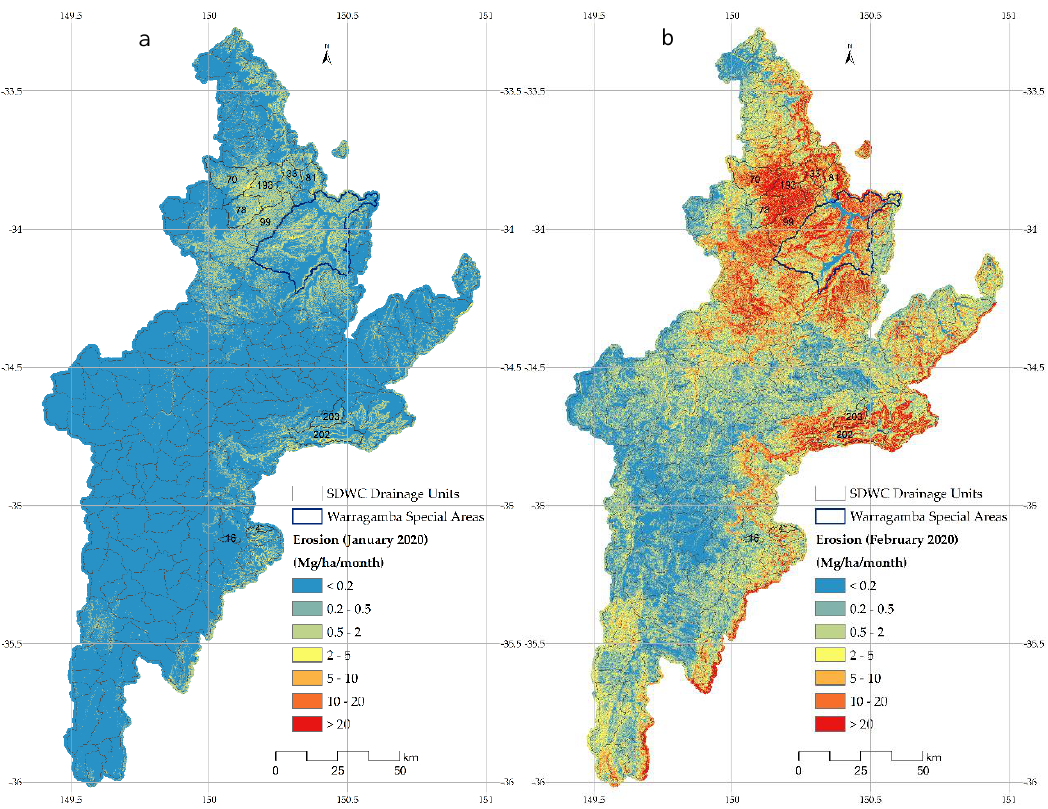
Figure 6. The hillslope erosion in January and February 2020 showing the impacts of fire and storm events on erosion, and the ten high erosion risk sub-catchment (labelled with IDs) across the Sydney drinking water catchment: ( a ) erosion before storm events; ( b ) erosion after storm events.